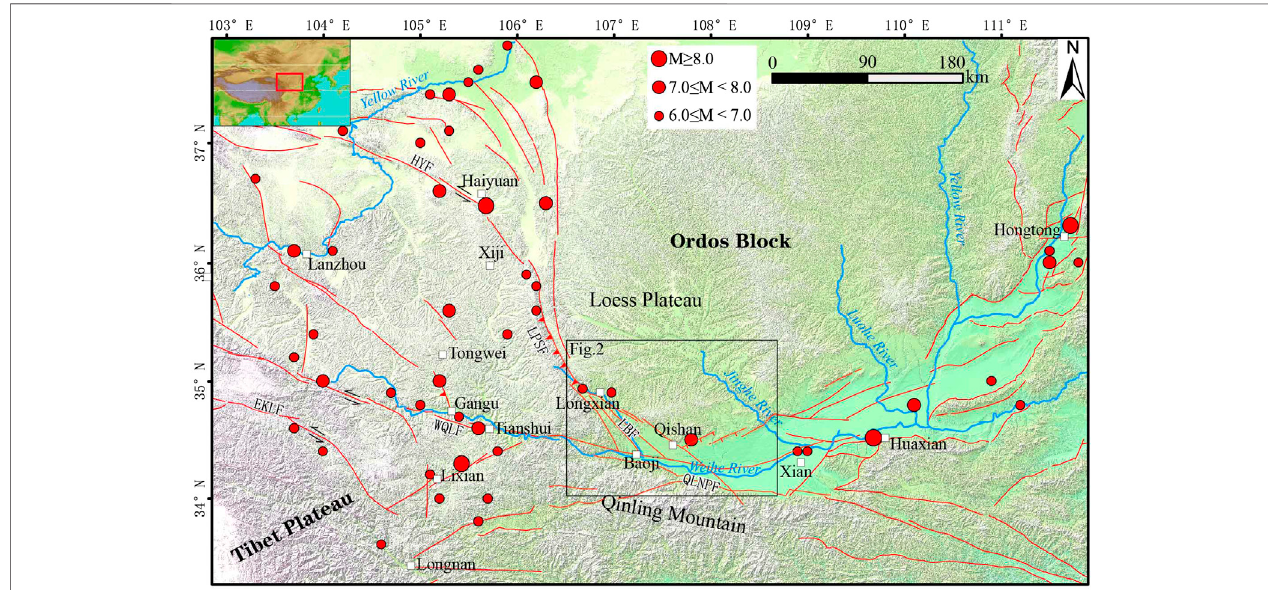
FIGURE 1 | Regional background map. LBF: Longxian Baoji Fault Zone; LPSF: Liupanshan Fault; HYF: Haiyuan Fault; WQLF: West Qinling Fault; EKLF: East Kunlun Fault; QLNPF: West Qinling North Margin Fault; The black box represents the range of Figure 2 .